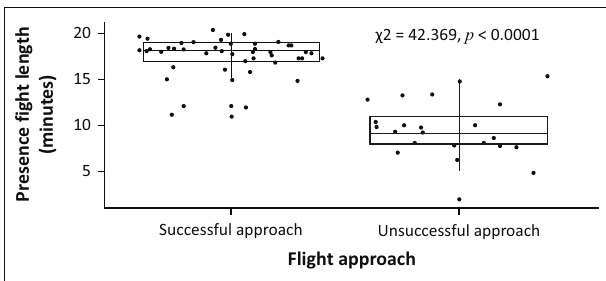
FIGURE 3: A significant difference was detected between the two groups (whether an elephant or group had a successful or unsuccessful approach flight) with significance levels measured at p < 0.05.